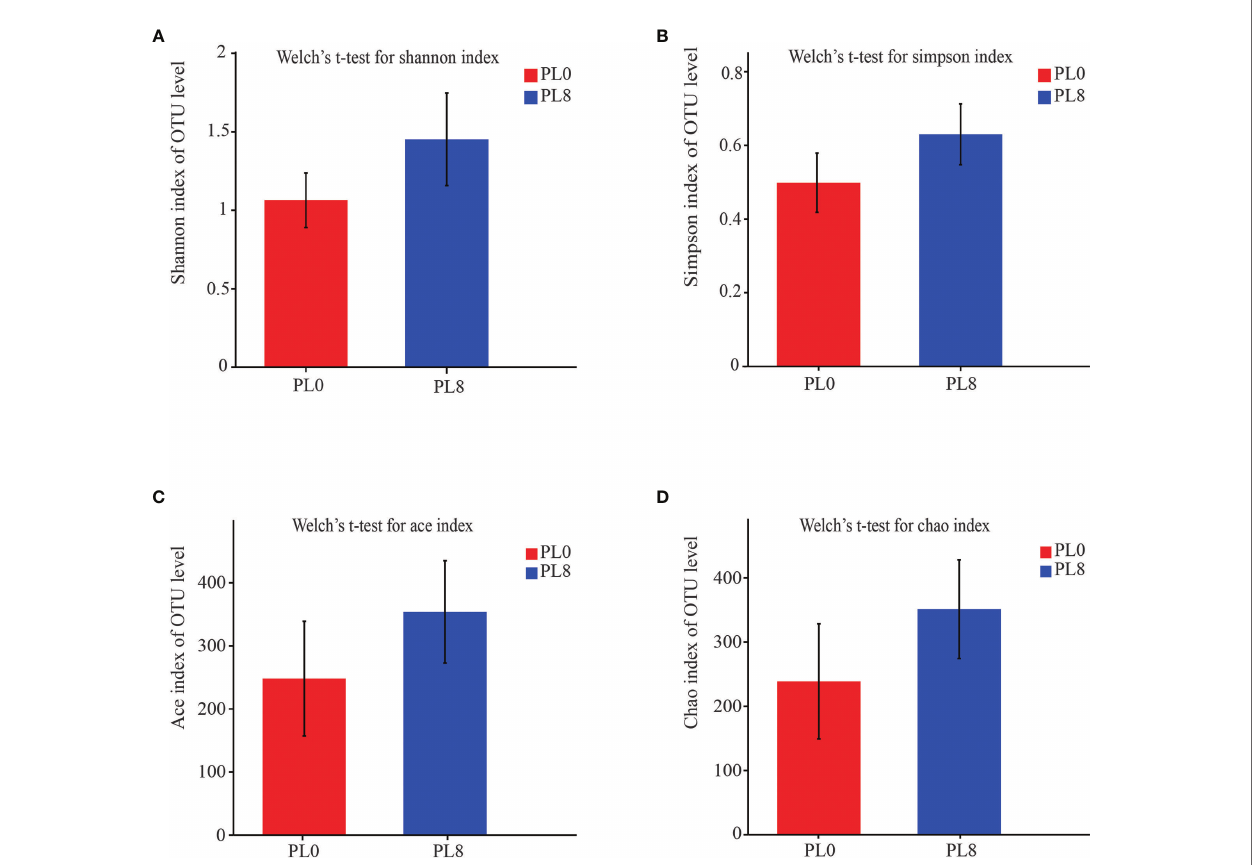
FIGURE 6 | The alpha diversity comparisons analysis, including Shannon diversity index (A) , Simpson diversity index (B) , Ace species richness index (C) and Chao species richness index (D) of microbial communities in the intestine of largemouth bass in the PL0 (control) and PL8 groups. Values (mean ± standard error of the mean, SEM) in bars that have the same letter are not signi fi cantly different ( P > 0.05; Welch ’ s t-test) between treatments (N =